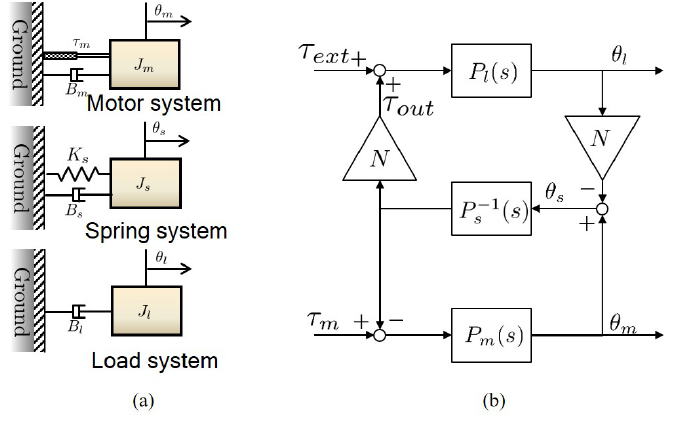
Figure 12. Dynamic modelling of RFSEA. ( a ) free-body diagrams of RFSEA and ( b ) block diagram representation of RFSEA